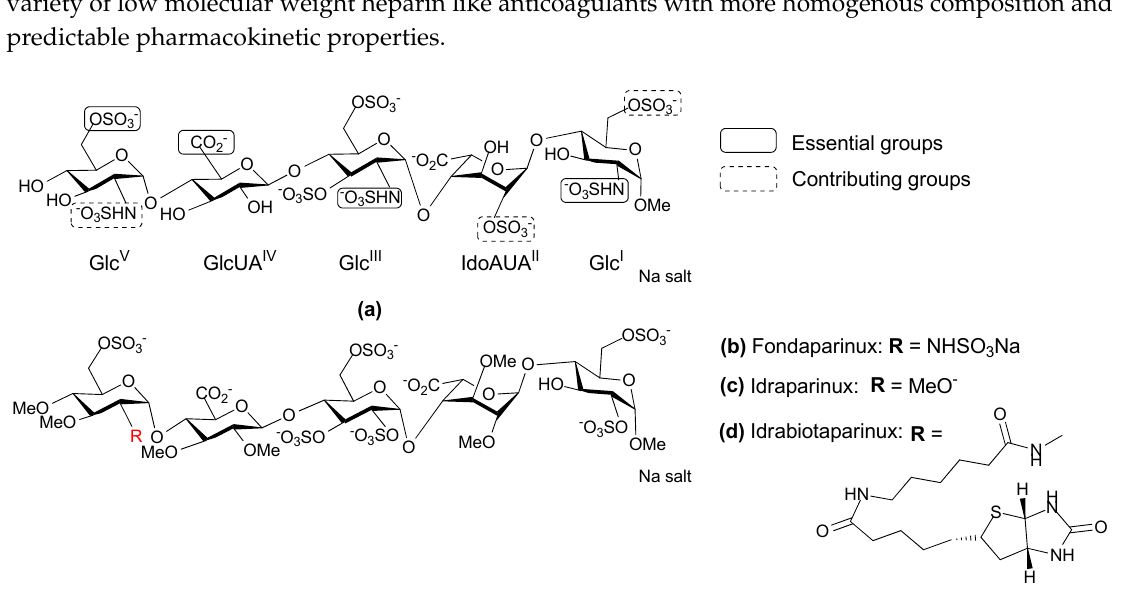
Figure 2. Chemical structure of heparin pentasccharide derivatives. ( a ) The antithrombin III binding pentasccharide motif of heparin; ( b – d ) Structure of synthetic analogues of the antithrombin III binding site of heparin.